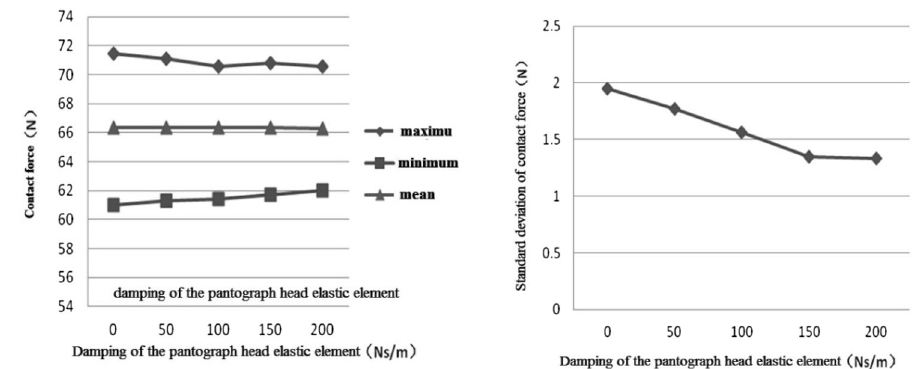
Fig. 14 The influence of damping of right pantograph head elastic element on power collection quality in curved